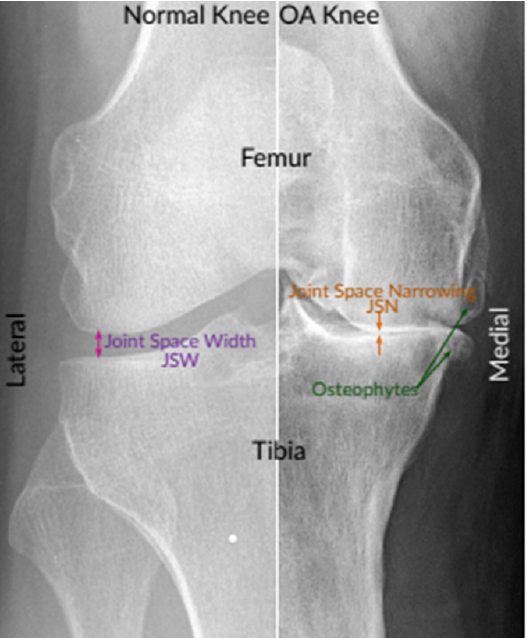
Figure 1. An instance of X-ray images of the normal knee and severe OA knee. On the left is a normal knee, and on the right is an OA knee. This image shows joint compartments, as well as joint space narrowing (JSN) and osteophytes [10]. Grade 0 denotes healthy joints in which the radiographic features of knee OA do not exist. Grade 1 denotes doubtful knee OA, which is the possibility of osteophytic lip and questionable JSN. Grade 2 denotes mild OA, which means there are clearly osteophytes as well as the possibility of JSN. Grade 3 denotes moderate OA, which means there are JSN, multiple osteophytes, and sclerosis. The last one, Grade 4, denotes severe OA because of large osteophytes in the joints marked by JSN and severe sclerosis. Figure 2 shows knee joint samples from all grades of KL